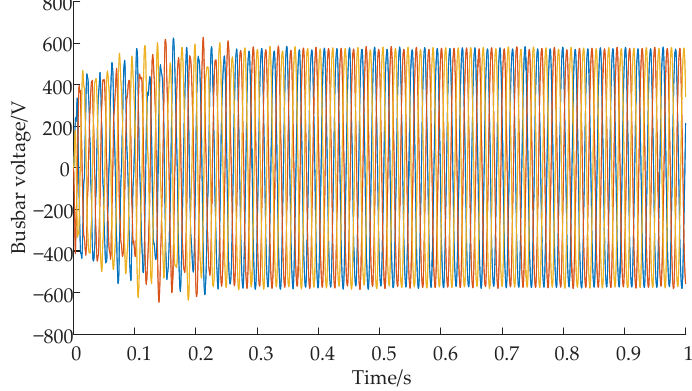
Figure 19. The bus voltage waveform when n 1 = 0.001 V/var and n 2 = 0.004 V/var.